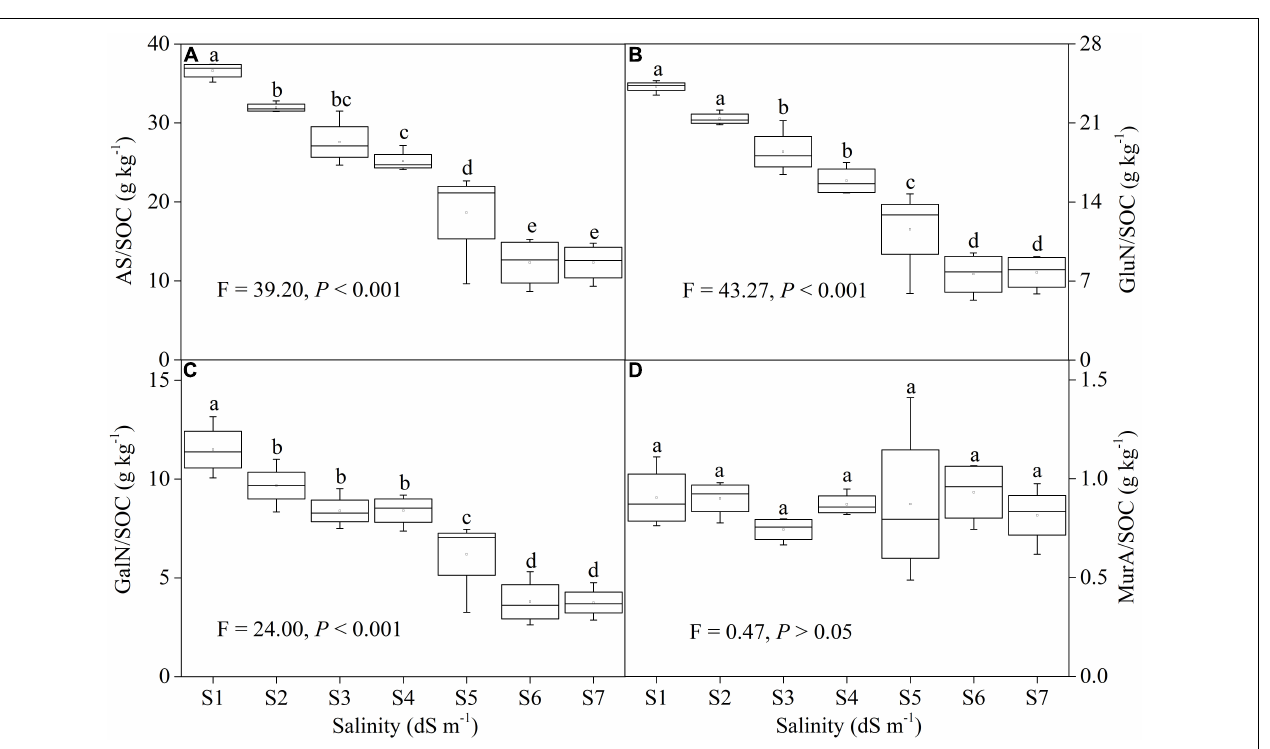
Frontiers in Ecology and Evolution |